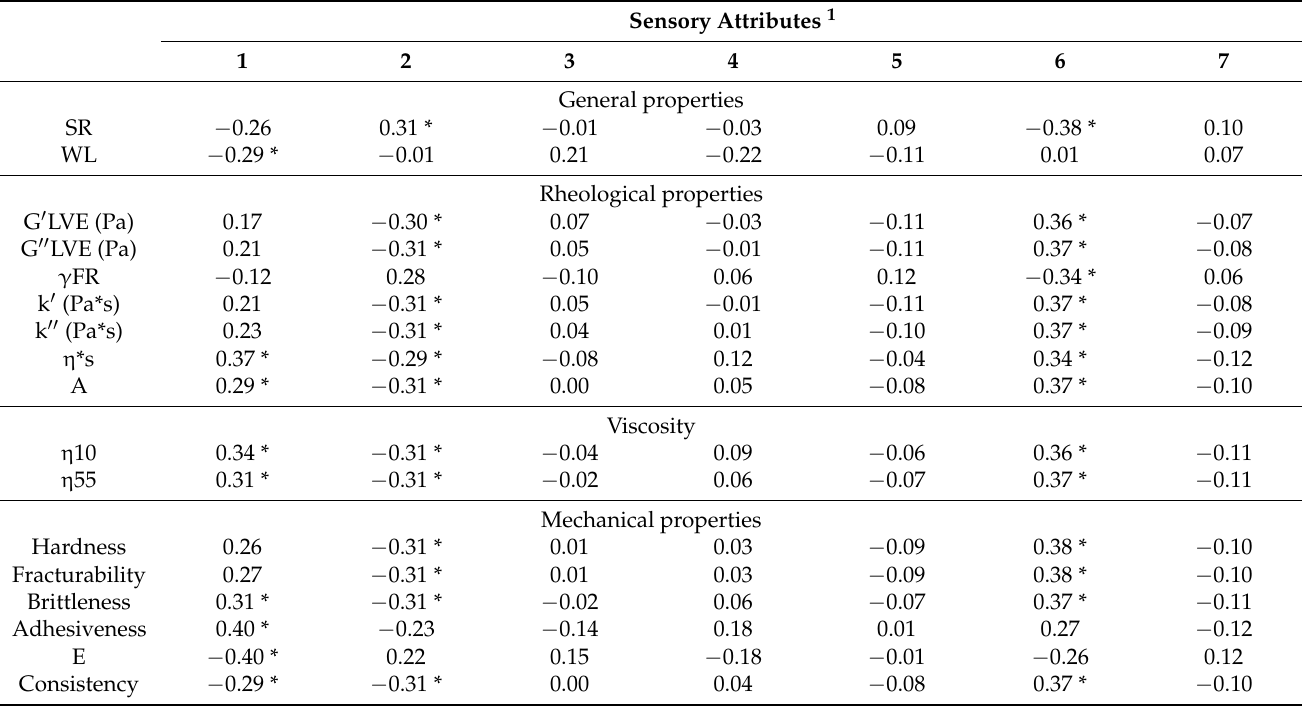
Table 6. Correlations between volunteers’ evaluations of texture and the mechanical and rheological properties of